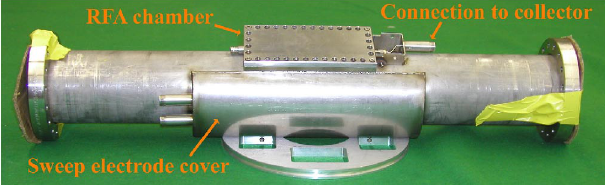
electrode.FIG. 2. (Color) Detector assembly before installation in the quadrupole magnet. Labeled components include the RFA cham- ber with vacuum cover plate, the sweeping electrode housing (cover), and the signal connector to the collector plate.